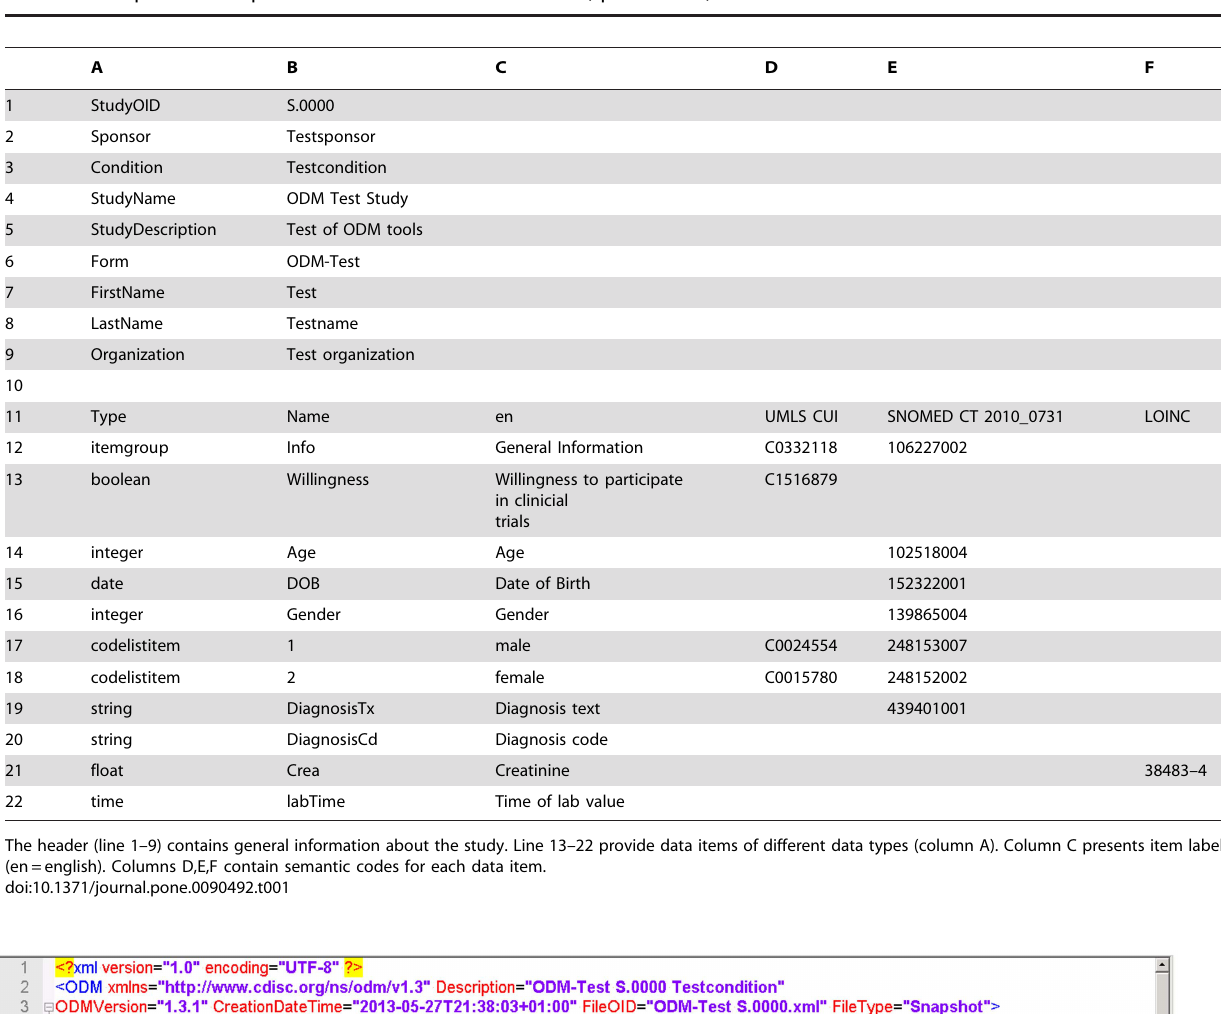
Table 1. Simplified example of data model in office format (spreadsheet).